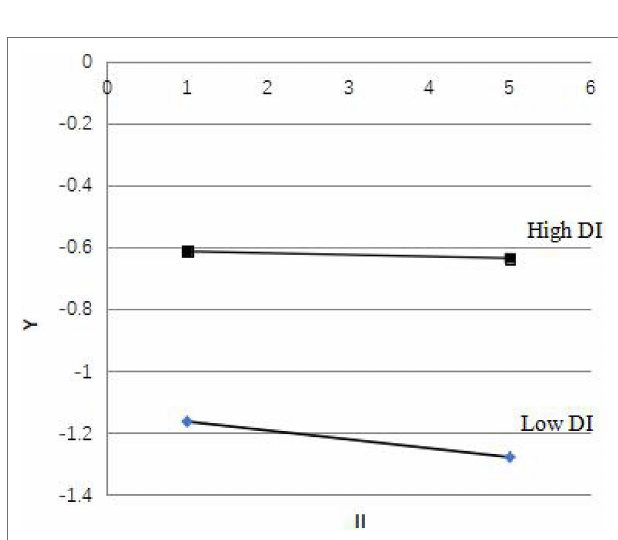
FIGURE 2 | The interaction effect of employee direct involvement on employee indirect involvement. DI, direct involvement; II, direct